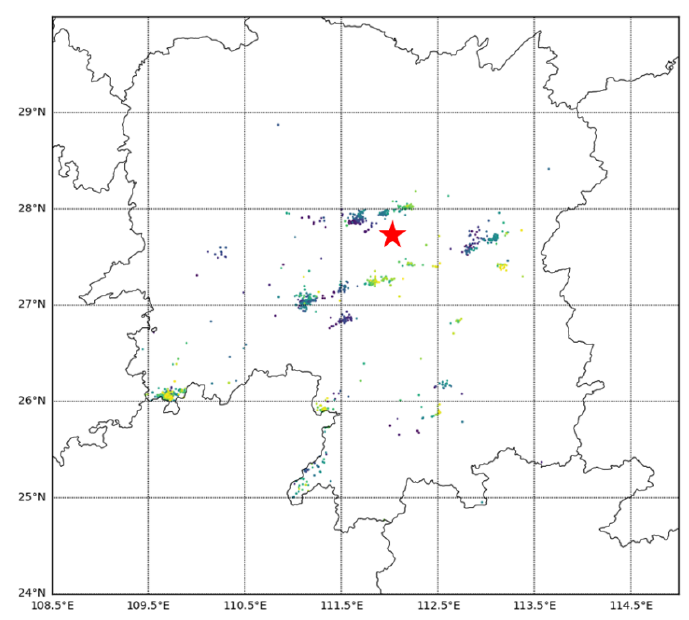
Figure 8. Thunderstorm map. The red pentagram represents a site location.